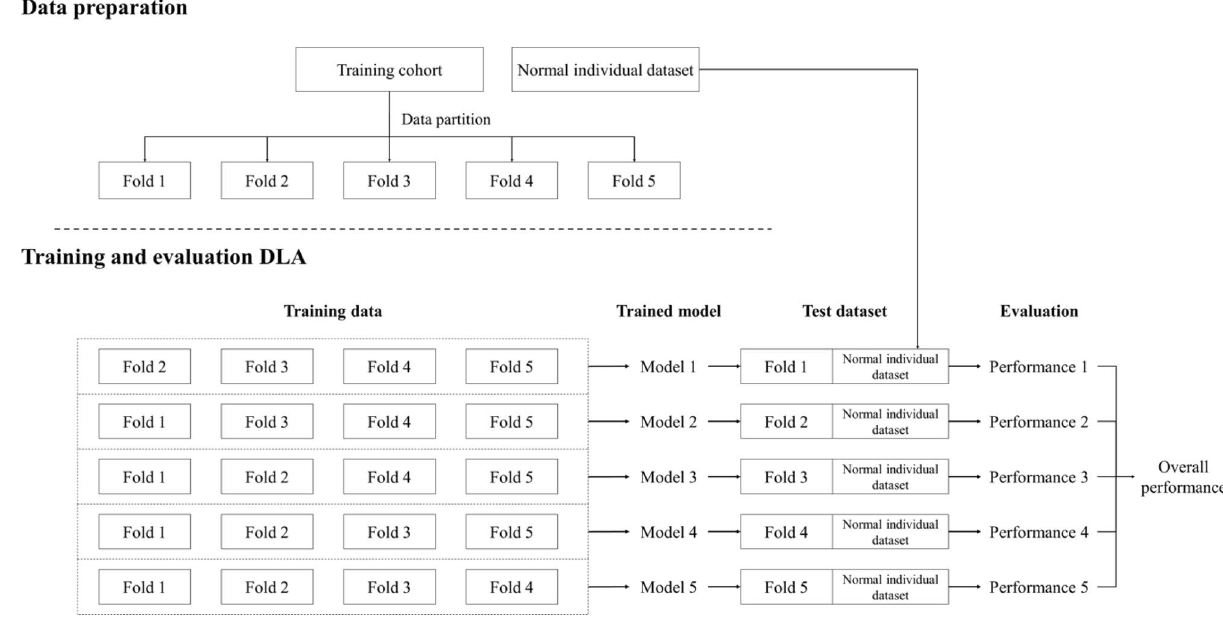
Figure 6. Five-fold cross-validation diagram using training cohort dataset and normal individual